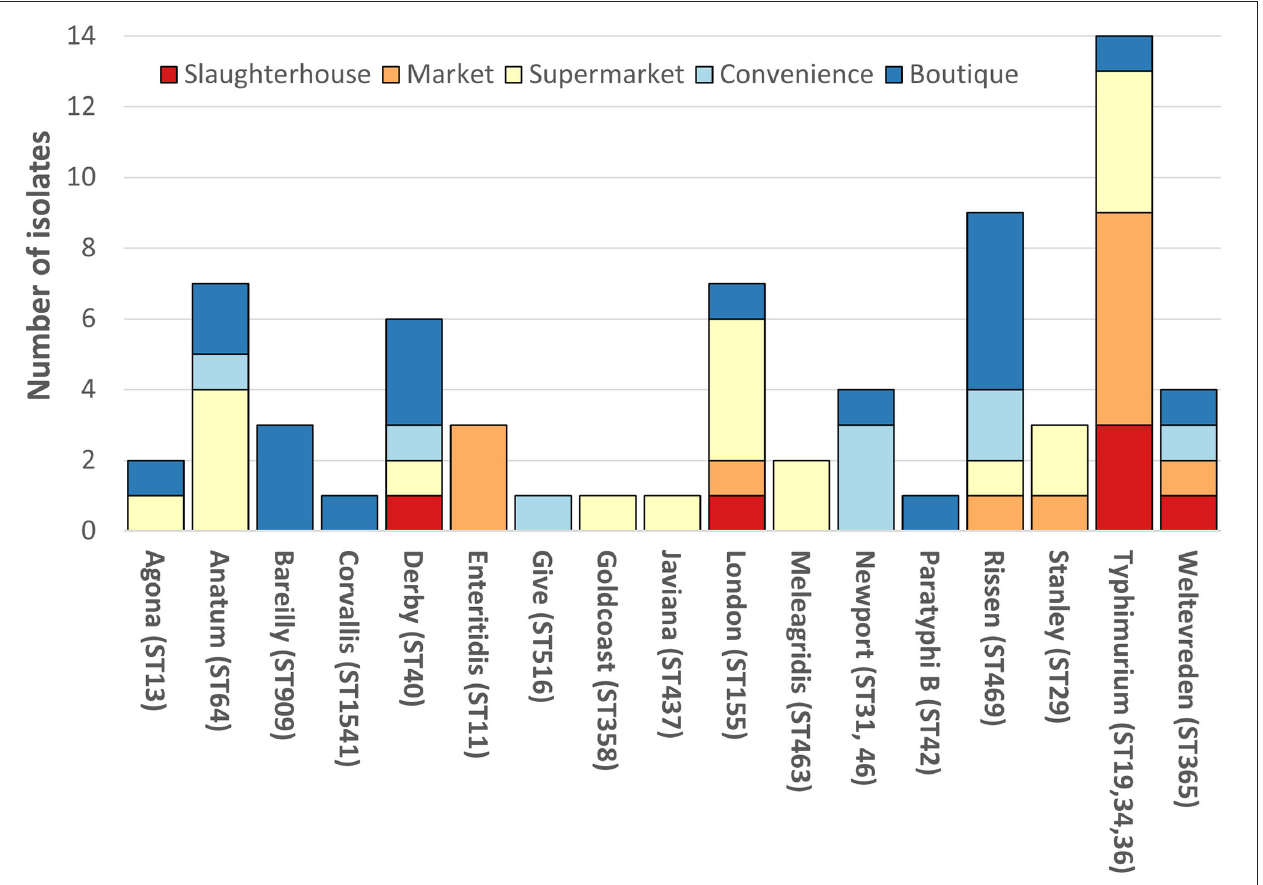
FIGURE 1 | Breakdown of non-typhoidal salmonella (NTS) serotypes. Each vertical bar represents serotype with multi-locus sequence type(s) given in brackets. NTS serotypes by isolation location; red, slaughterhouse; orange, market; yellow, supermarket; light blue, convenience store; dark blue, boutique store. SafePORK serotype in silico predicted, PigRISK phenotypically serotyped and corroborated by in silico analysis. Corvallis, Corvallis or Chailey; Goldcoast, S. Goldcoast or S. Brikama; Javiana, II 9,12:l,z28:1,5 or S. Javiana, Typhimurium includes S. Typhimurium and potential monophasic variant of S. Typhimurium. ST34 includes SL406a single SNP variant in purE of